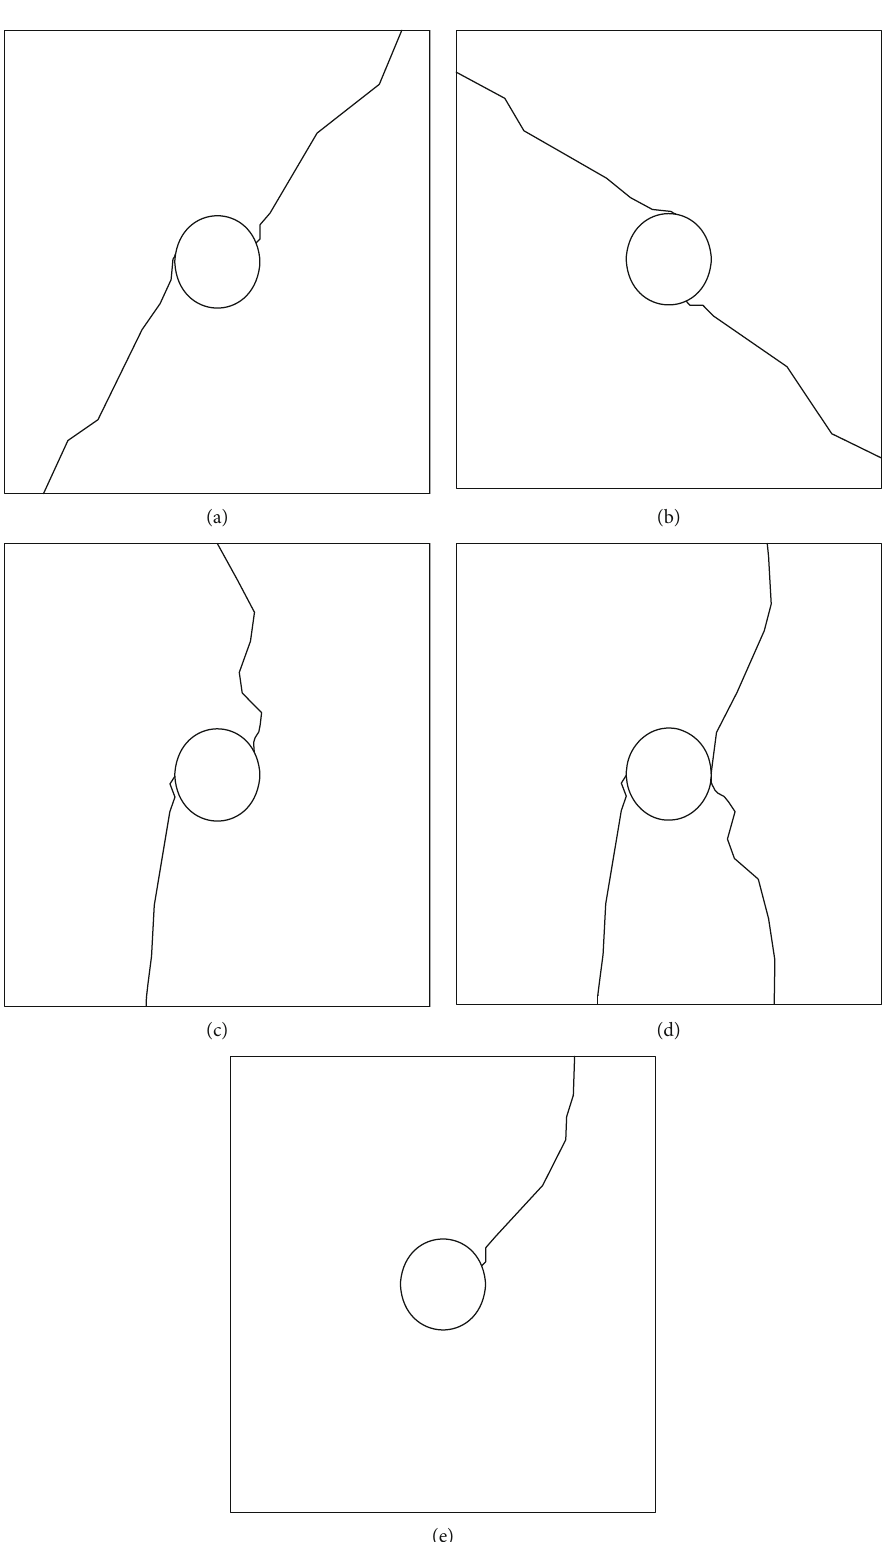
Figure 8: Classi fi cation of failure modes of specimens with a hole. (a) Single bevel type I. (b) Single bevel type II. (c) Single bevel type III. (d) Bevel T type. (e) Single part shear